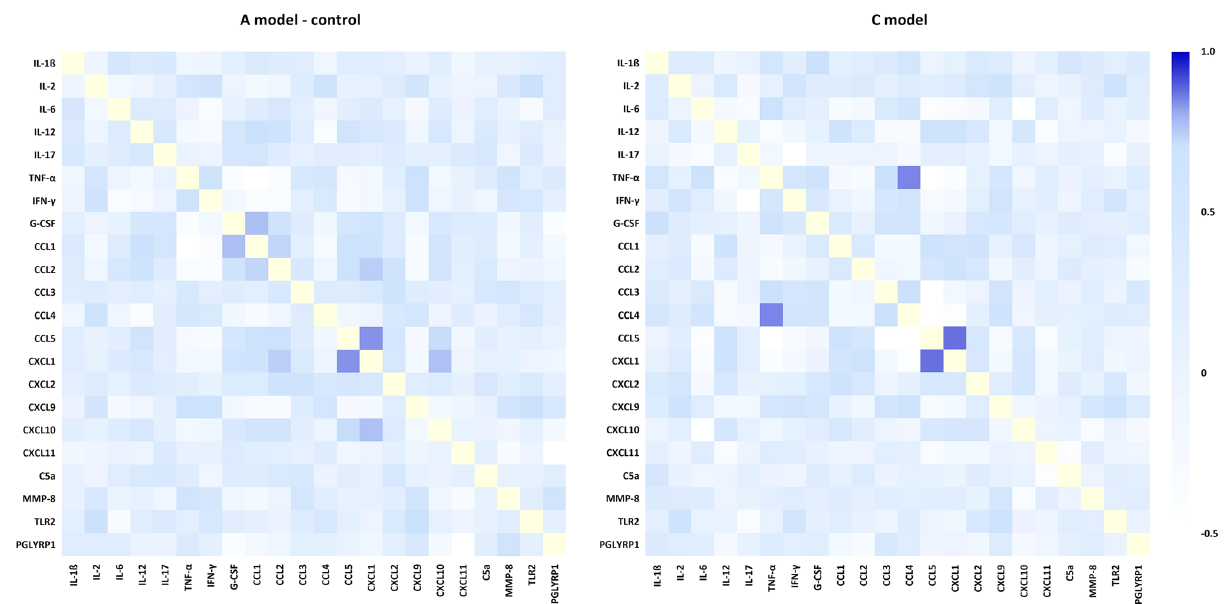
Figure 5. Pearson’s correlation analysis between mean protein log concentration in the plasma isolated from whole human blood samples ( n = 20) infected with the Staphylococcus aureus Newman strain precultured on Mueller–Hinton agar non-supplemented (A model—control); and supplemented with 1% (v/v) Tween 80 and trans -anethole at the subinhibitory concentration (5%, v/v, C model). The heatmap represents the r scores (+ 1 blue to − 0.5